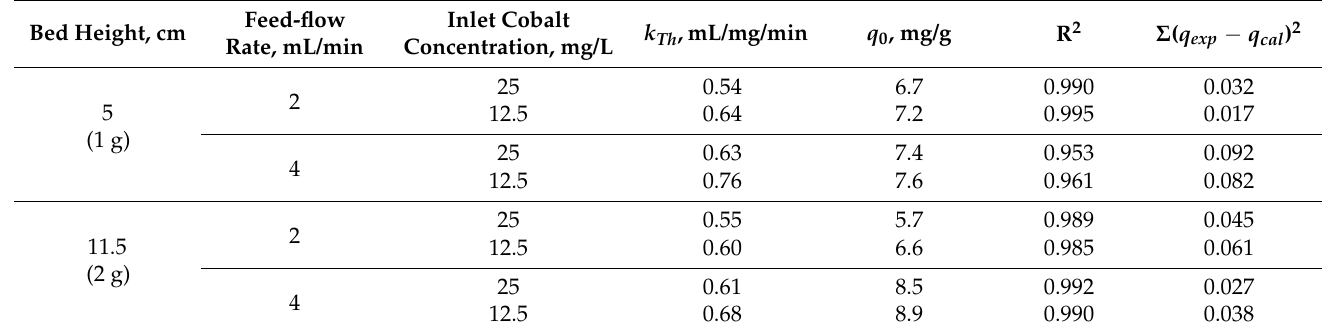
Table 3. Constants of the Thomas model for the fitting of the breakthrough